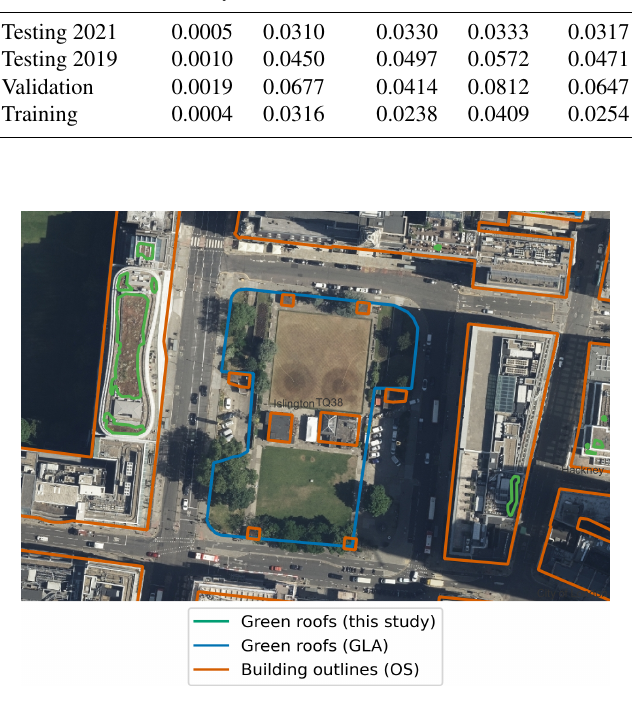
Figure A1. Example of ground-level green space misclassified as green roof in the GLA dataset (in blue) (Greater London Authority, 2014). Building outlines according to OS VML are shown in orange; our results are shown in green. Image location is shown in Fig. A3. Imagery © GetMapping Plc. Building polygons are OS data © Crown copyright and database rights 2022.